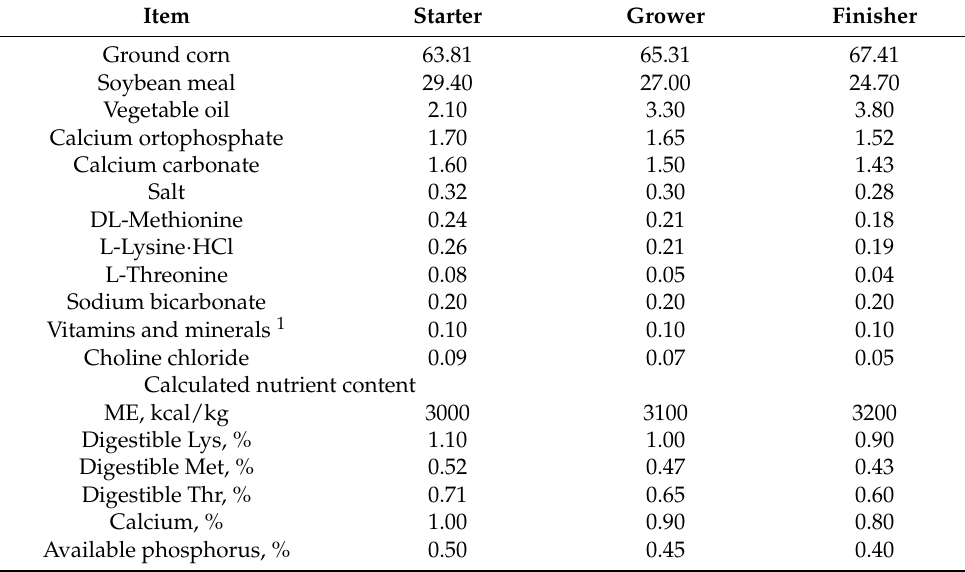
Table 1. Composition of the experimental